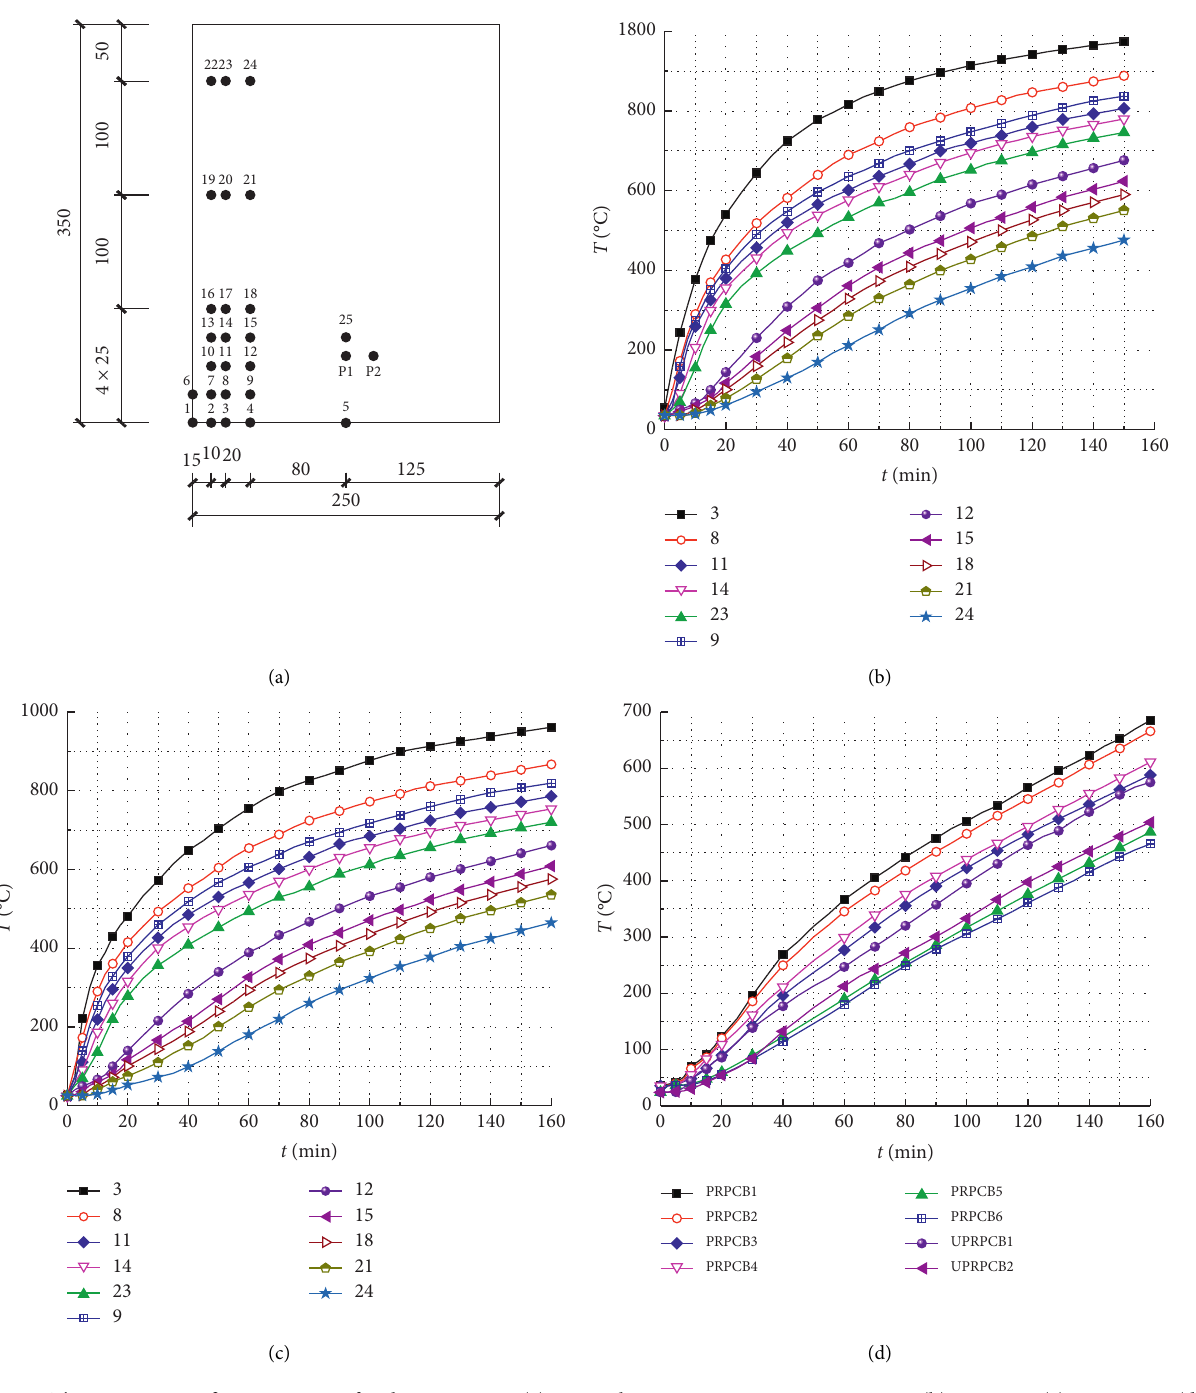
Figure 5: The temperature-fire time curves for the specimens. (a) Internal temperature monitoring points. (b) PRPCB1. (c) UPRPCB1. (d)